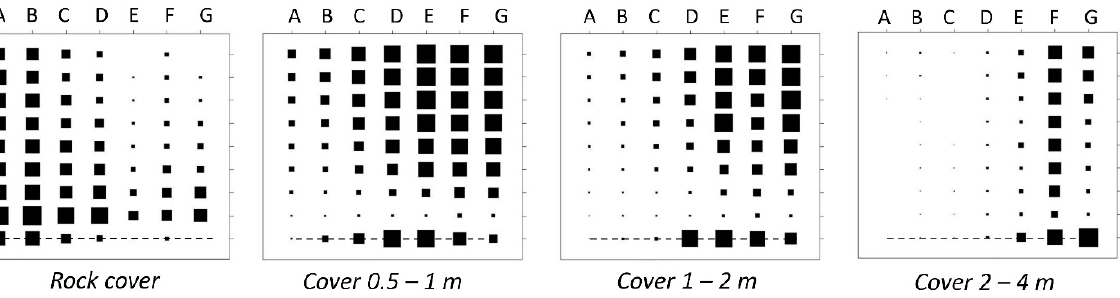
Figure A4. Mean cover values of the rock and three vegetation layers in seven classes (A to G) corresponding to a vegetation gradient ( x -axis) and the first eight years after a fire ( y -axis) (see Figure 1). Dashed line: the prefire gradient. The dimension of a square is normalized by the maximum cover of the layer considered.